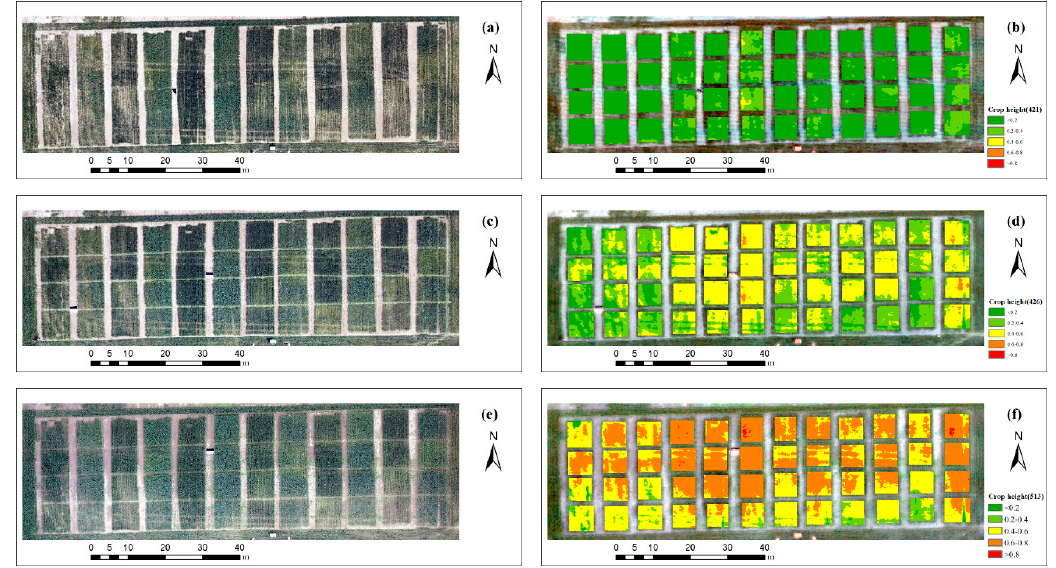
Figure 2. UAV-UHD hyperspectral images and corresponding crop height on ( a , b ) 21 April; ( c , d ) 26 April; and ( e , f ) 13 May 2015.